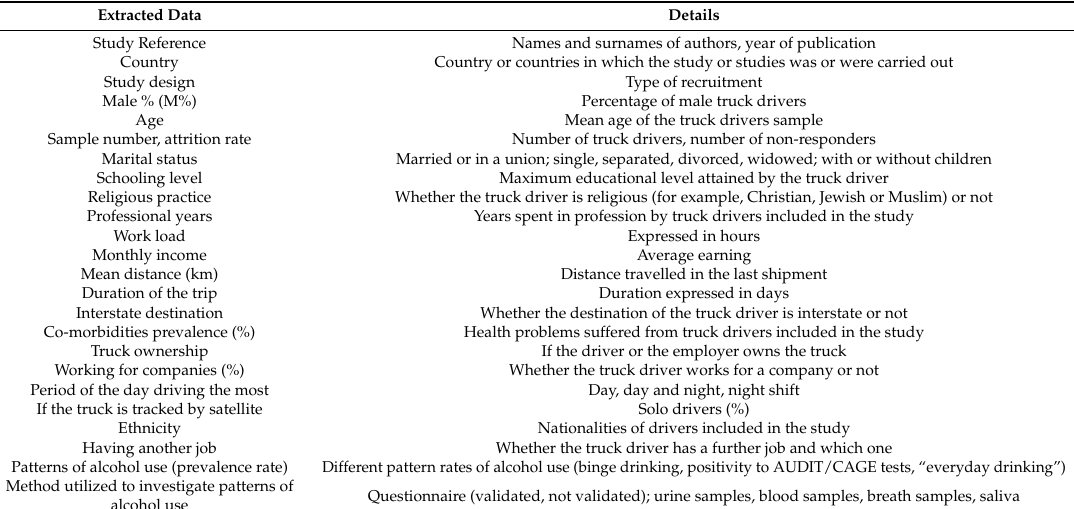
Table 2. Data extracted from the included studies in the current meta-analysis. Extracted